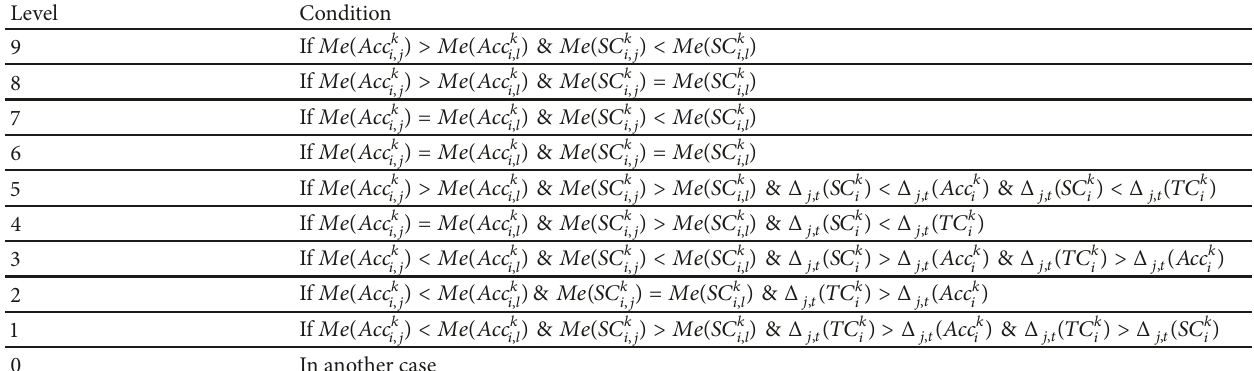
Table 4: Level of gains where ‘ = , < , > ’ denotes statistically meaningful equality and differences, 𝑀𝑒 represents the median, and 𝑗 < 𝑙 . Level